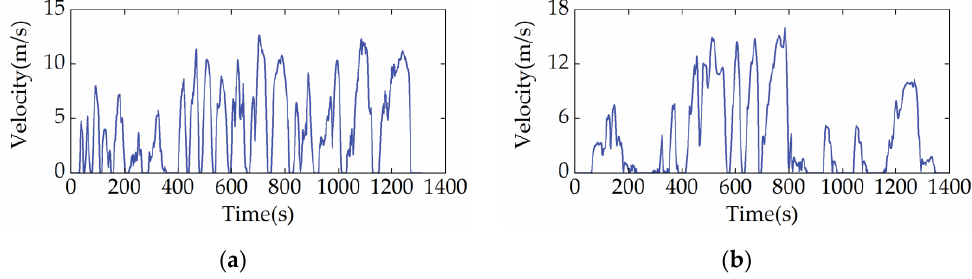
Figure 6. Driving cycles used for algorithm training and validation. ( a ) CHTC-B cycle; ( b ) WVUCITY cycle.